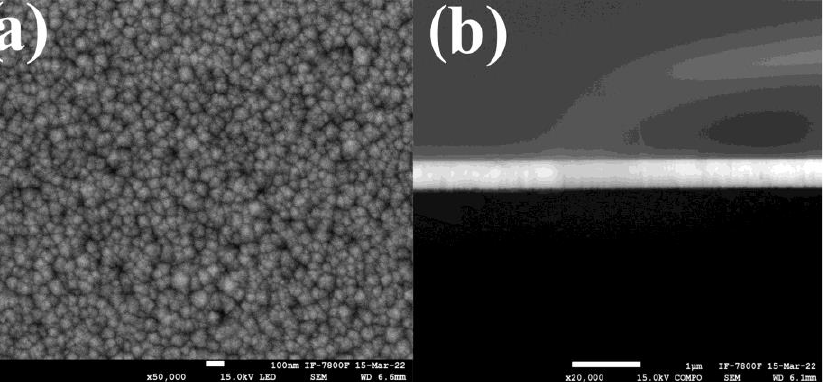
Figure 3. (a ) SEM micrograph for NiO: Li (10%) deposited on glass. ( b ) SEM Cross section image of the same film.